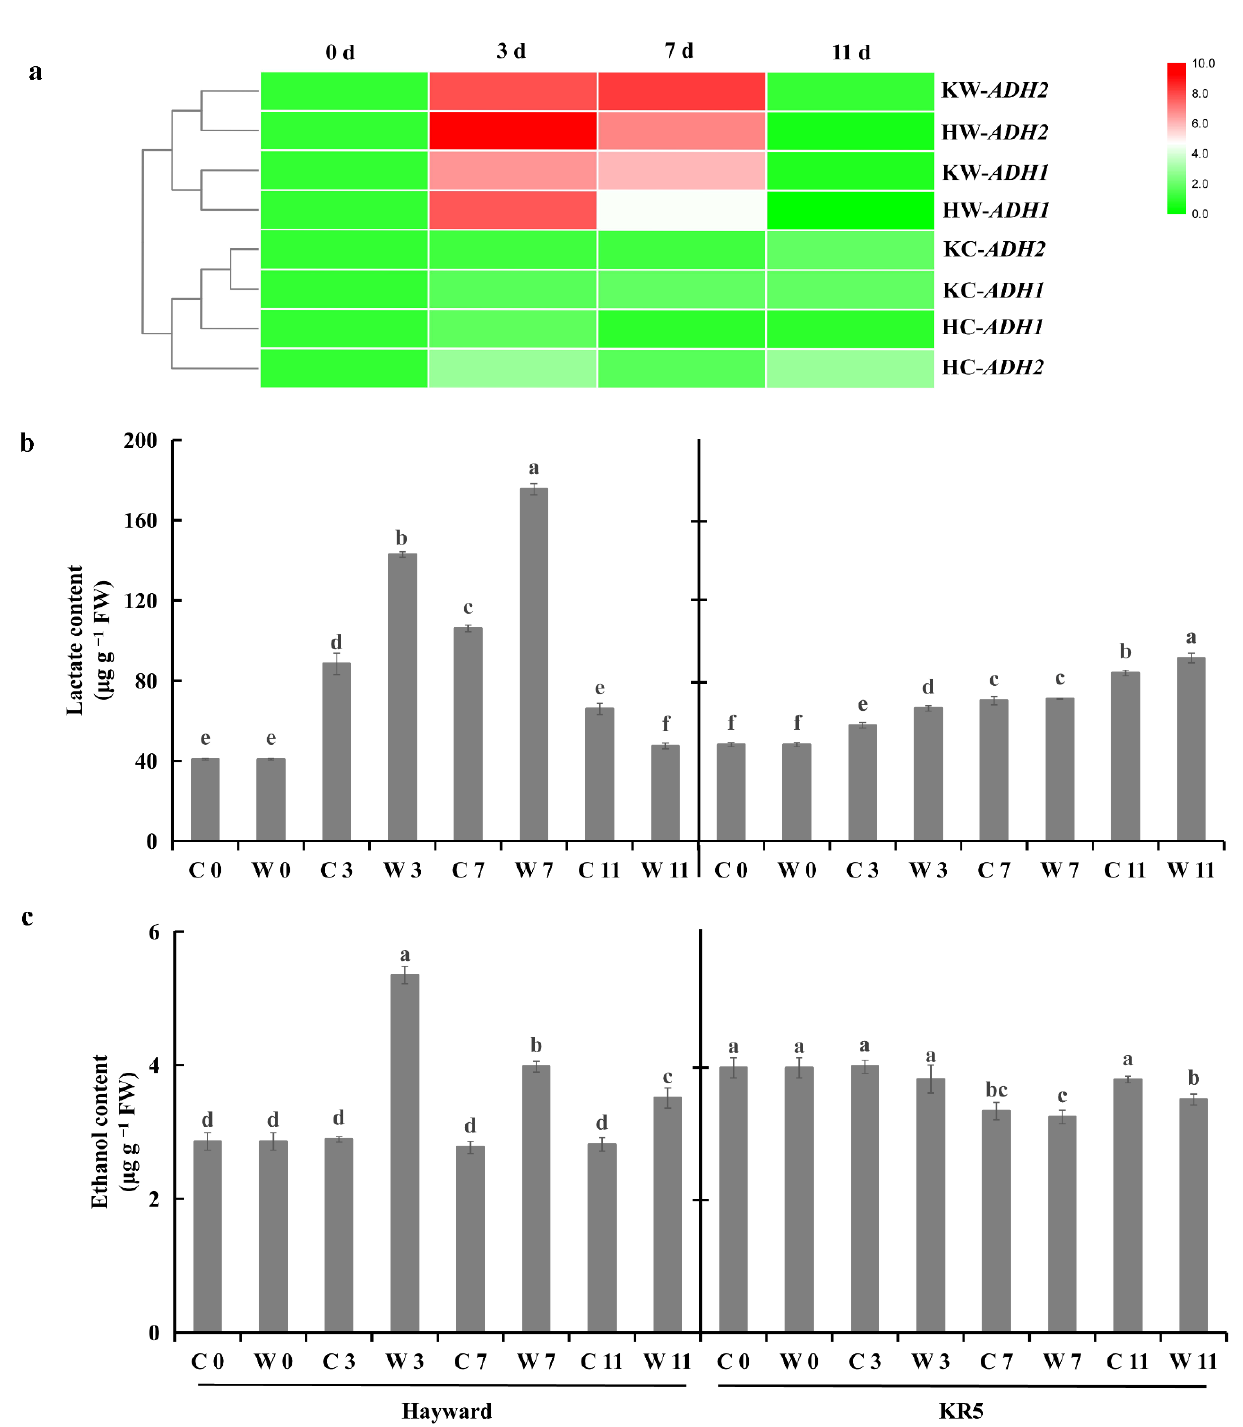
Figure 6. Gene expressions and metabolite contents in ‘Hayward’ and KR5 roots under control or waterlogging conditions. ( a ) Expression levels of AdADH1 and AdADH2 ; ( b ) lactate contents; ( c ) ethanol contents. C 0, C 3, C 7, and C 11 indicate 0, 3, 7, and 11-d controls, respectively. W 0, W 3, W 7, and W 11 indicate waterlogging treatments of 0, 3, 7, and 11 d, respectively. Values are the mean ± SD ( n = 3). Significant differences between treatments per genotype at p < 0.05 are indicated by different letters over columns (Duncan’s test).